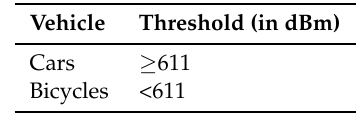
Table 2. Threshold rules for vehicle identification using Heisenbergstrasse data.